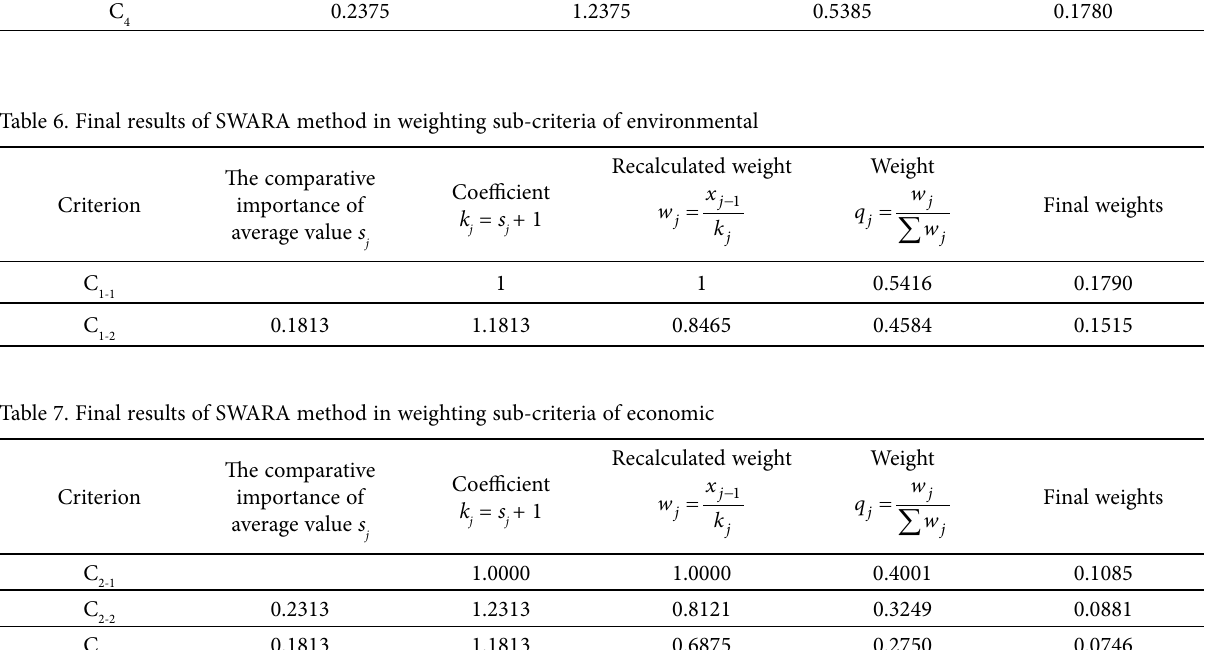
Table 8. Final results of SWARA method in weighting sub-criteria of chemical